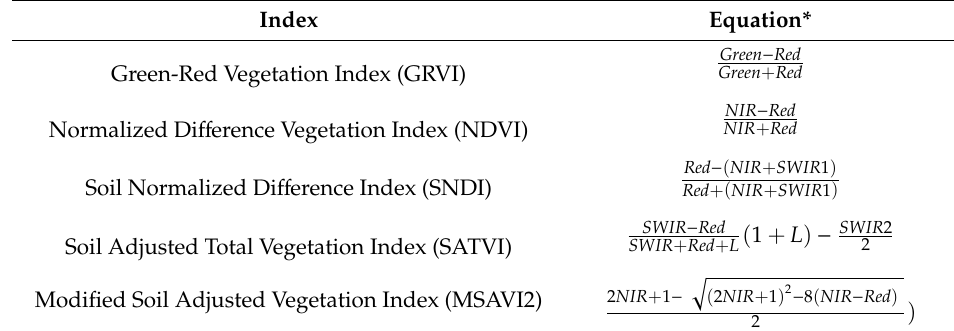
Table 2. Equations for indices used in this study. Color names refer to the corresponding image band.